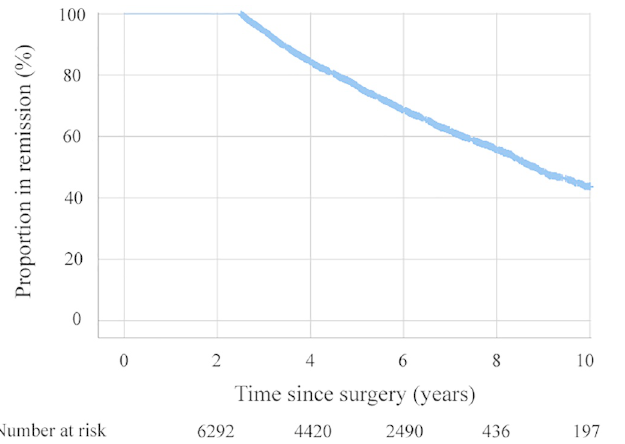
Fig 2. Relapse-free survival for patients experiencing remission of hypertension at 2 years after metabolic surgery (unadjusted Kaplan–Meier curve).